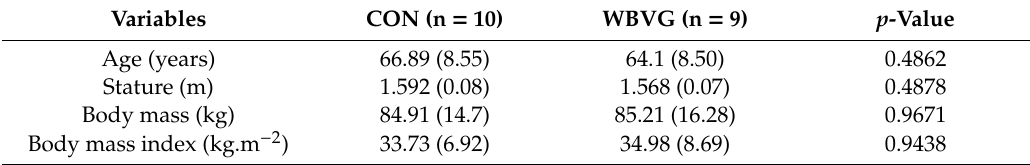
Figure 2. Flowchart with some information about the individuals that participated in the study and the crossover intervention. CON—control group; WBVG—vibration group. Table 1. Mean (SD) of demographic characteristics of participants at baseline (n = 19).